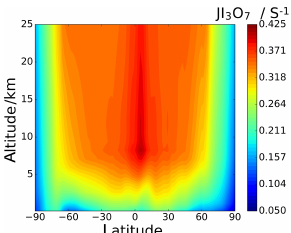
Figure 14. Annual zonal-average vertical J value profile for I 3 O 7 (not included in